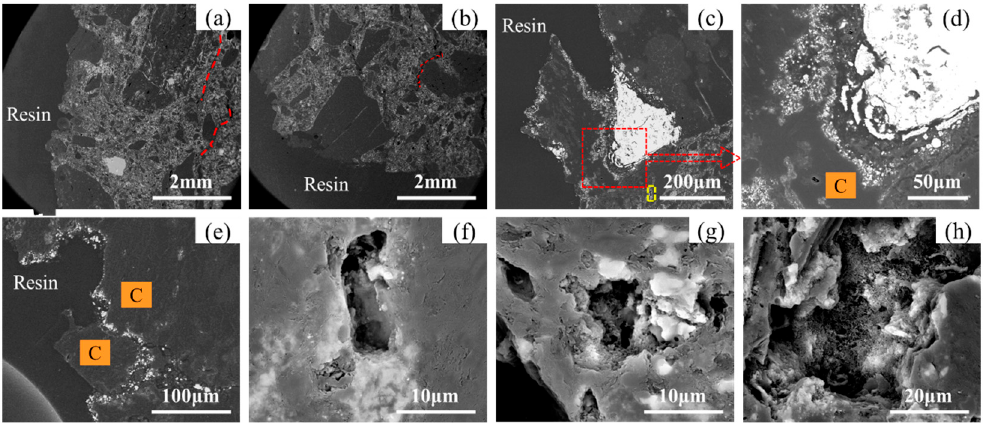
Figure 14. ( a – h ) Microscopic morphology of D after corrosion.